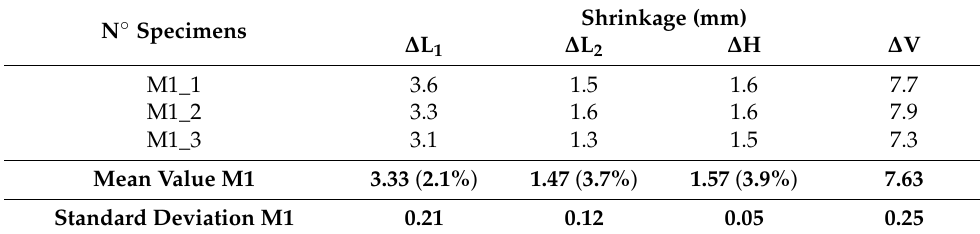
Table 8. Linear and volumetric shrinkage of mortars M1–M4.